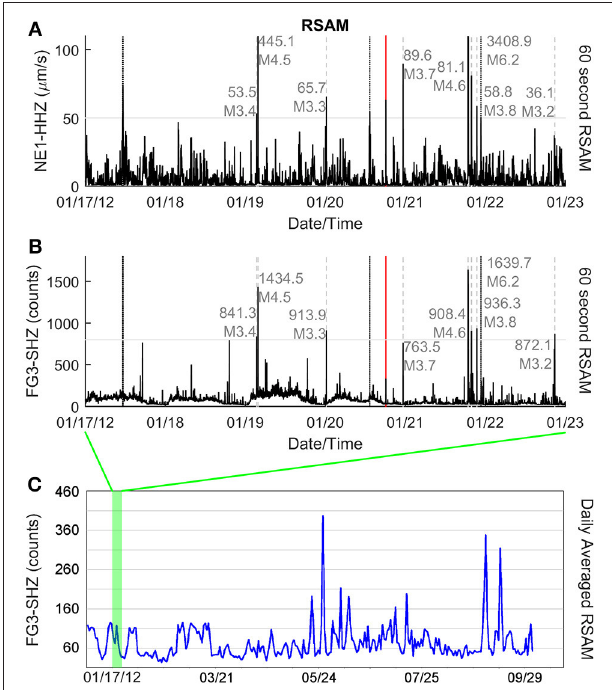
FIGURE 5 | Real-time Seismic Amplitude Measurement (RSAM) from station NE1 (A) and FG3 (B,C) . Each sample in a and b is the mean amplitude of a 60s, non-overlapping window of data, high pass filtered at 1Hz. Gray dashed lines are regional tectonic earthquakes, with associated numbers reporting RSAM values (in µ m/s for NE1 and uncalibrated counts for FG3) and reported magnitudes of regional tectonic earthquakes. Dotted lines represent peaks generated by volcanic tremor and red line marks the largest observed explosion. Solid gray horizontal line represents an arbitrary cutoff value, below which individual peaks are not described in detail. (C) plots the daily averaged RSAM from FG3 from January to September 2012. The green vertical bar represents the time periods captured in (A,B)